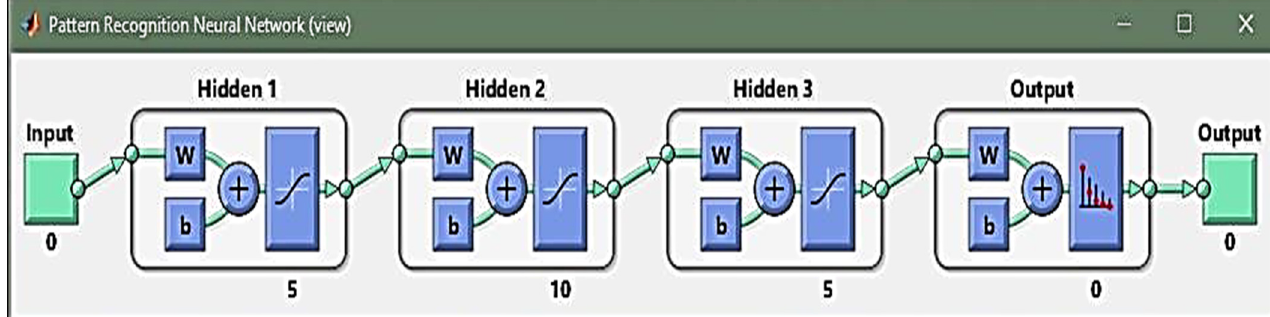
Figure 7. A neural network created in MATLAB. The flow chart of the neural network and the simulation of the transmission line system are shown in Figures 8 and 9, respectively.